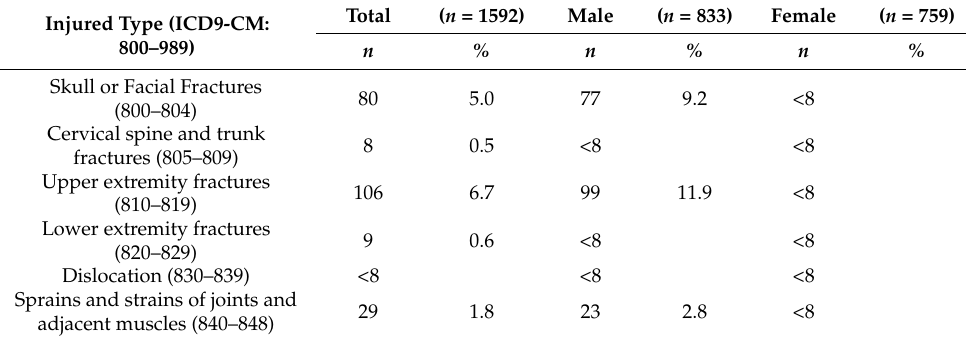
Table A3. Types of Injury of Violently Abused